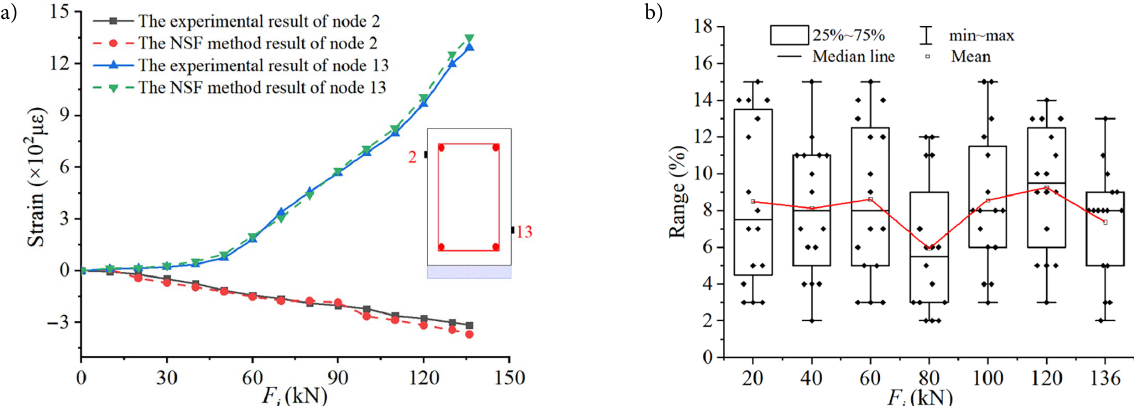
Figure 4. The error results of strain data mid-span section: a – Comparison curve of measuring points in mid-span section; b – Error of all